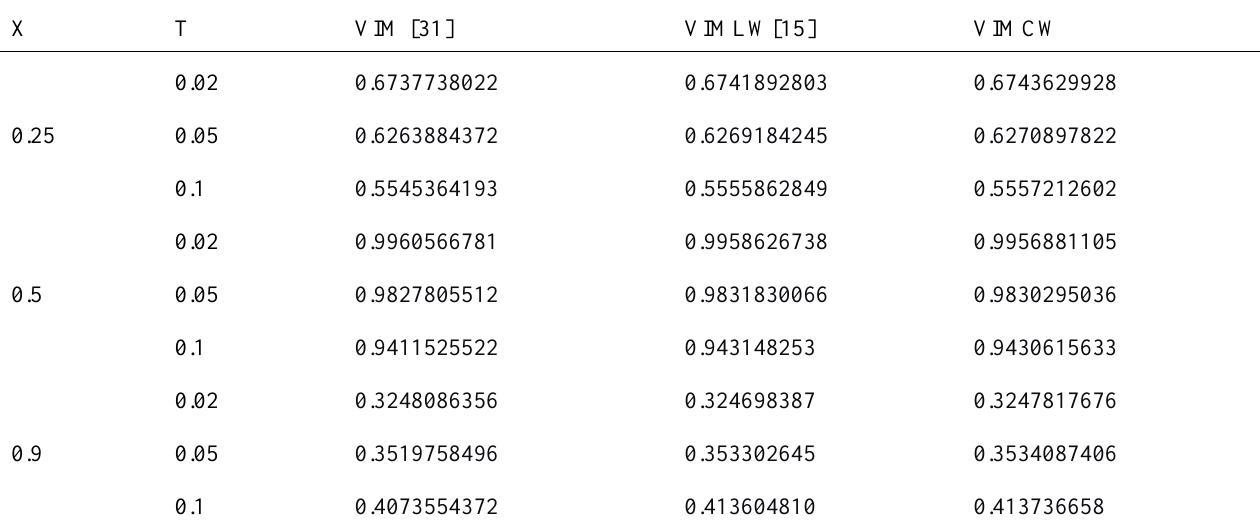
Analysis of the computed solution with different parameters, when 𝛼 = 𝛽 = 𝛾 = 1 and for 𝜀 =